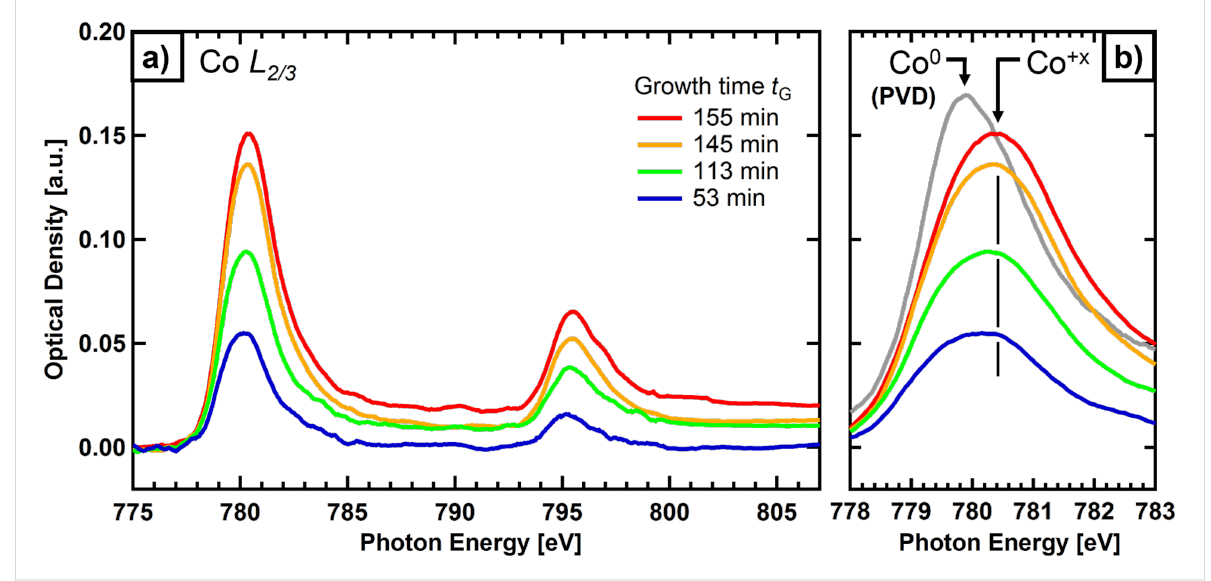
Figure 4: (a) Co L-edge X-ray absorption spectra of deposits prepared on a Si 3 N 4 membrane by EBID (0.2 C/cm 2 ) plus autocatalytic growth using Co(CO) 3 NO, with different growth times (indicated by colors); the spectra were vertically shifted to a common pre-edge baseline. (b) L 3 edge of the deposits at an enlarged photon energy scale, along with the spectrum of a Co layer produced by PVD as reference